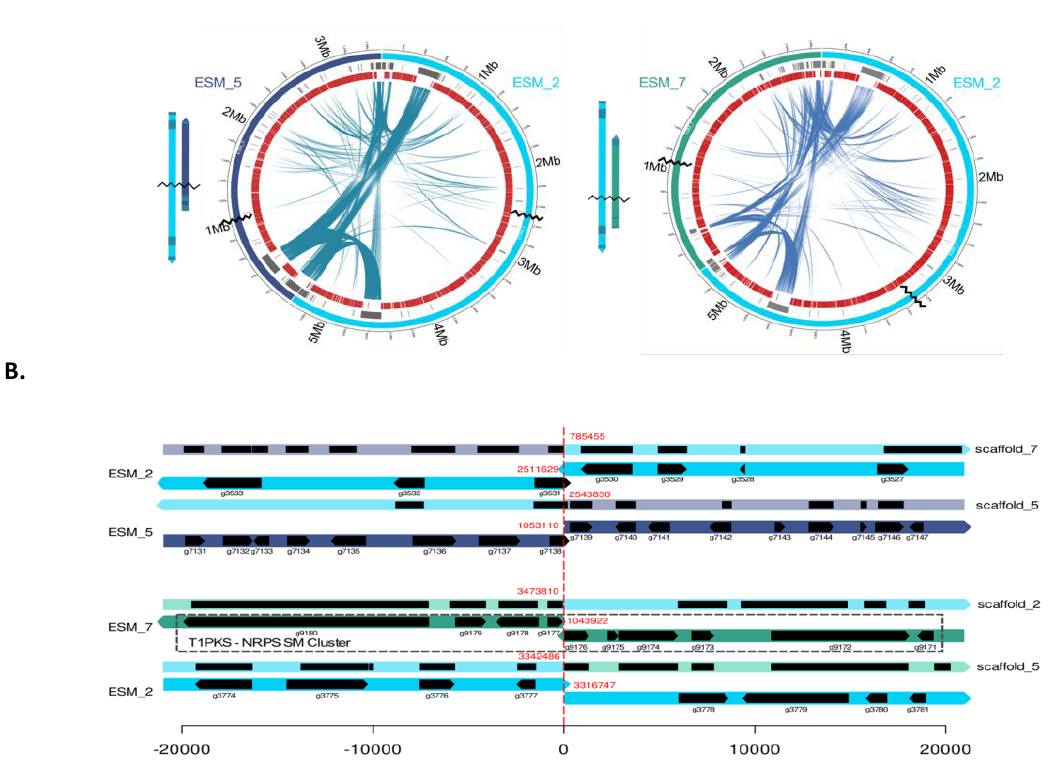
Figure 5. Zoom on the syntenic relationships between the three scaffolds of ESM015 involved in two major inter-chromosomal translocations. A . Circular representation of the ESM015 scaffolds involved in the inter-chromosomal translocations. Transposable elements are shown in grey and genes in red. Synteny breaks are represented by the black broken lines. All syntenic links obtained with Nucmer are shown. B . Schematic representation of the 40kb genomic regions around the chromosomal breaks for the three translocation events. Positions of the break for each scaffold are given in red, and ID of genes and their position on the scaffolds are in black. The secondary metabolite cluster T1PKS is indicated by the rectangle in dotted line on the scaffold ESM_7 of the ESM015